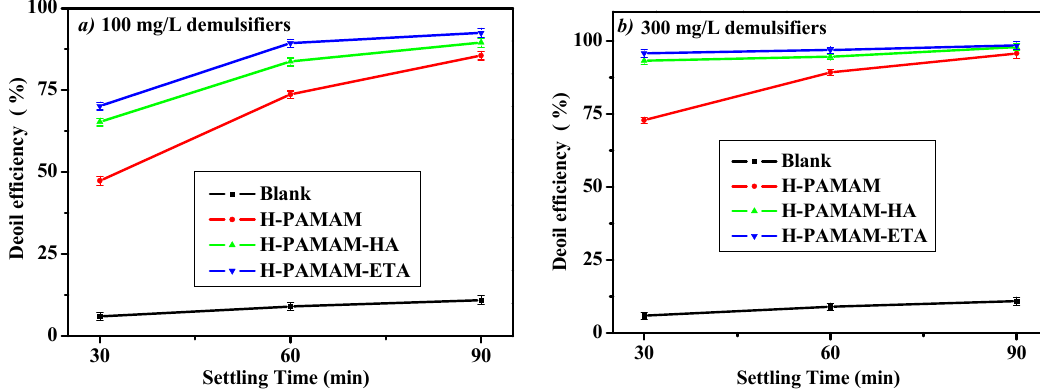
Figure 4. The deoil efficiency versus the settling time at 45 °C ( a ) for 100 mg/L demulsifier and ( b ) for 300 mg/L demulsifier.